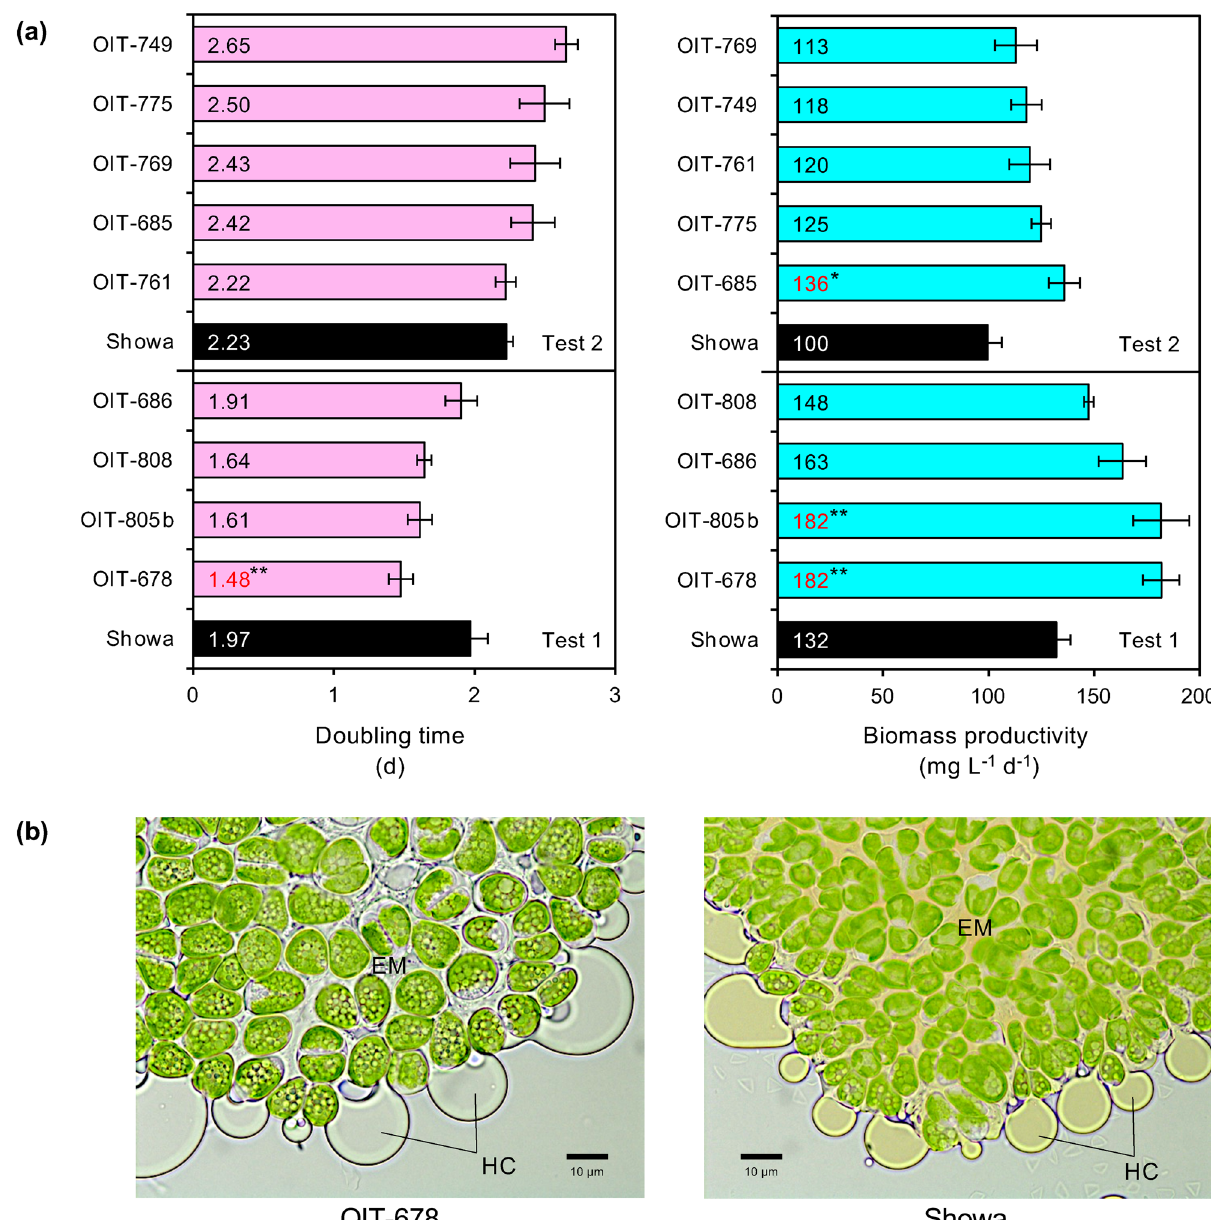
different from that of Showa are indicated by asterisks: *, P < 0.05; **, P < 0.01 (Dunnett’s post hoc test). ( b ) Microscopic view of a wild strain, OIT-678 and the Showa strain. The colony was flattened by cover glass, and hydrocarbons (HCs) exuded from extracellular matrices